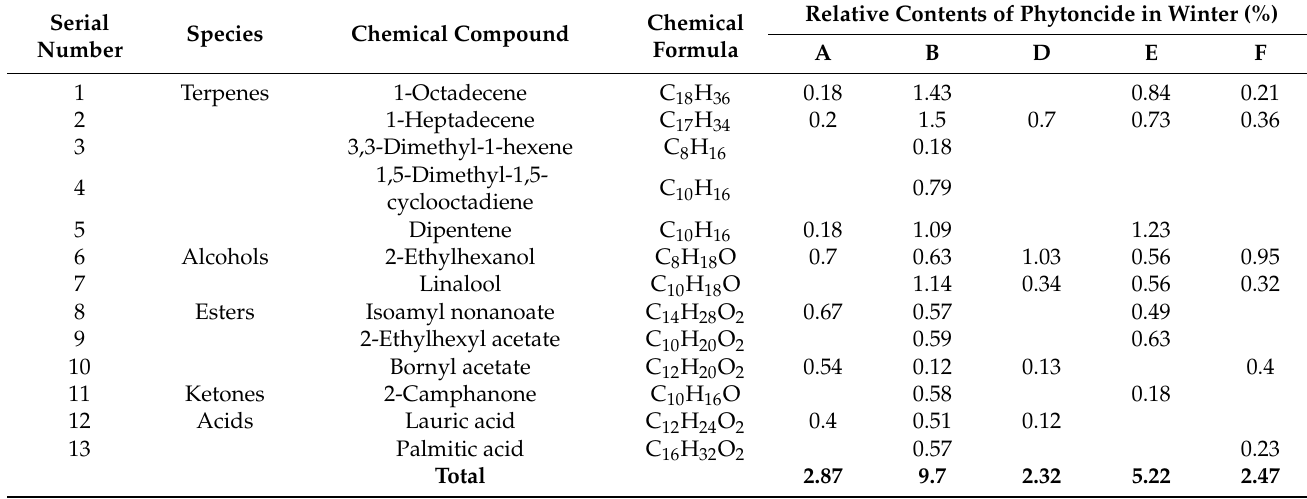
Table 7. Relative content of phytoncide